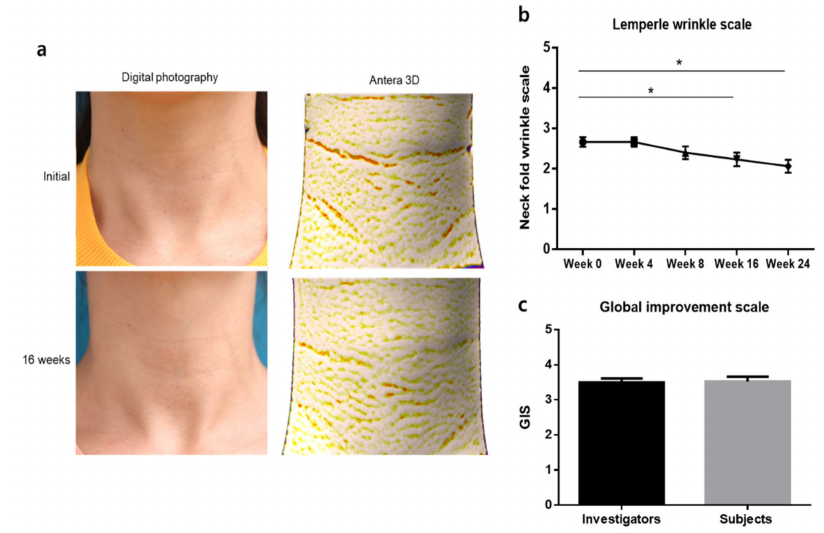
Figure 5. Improvement in neck wrinkles during the study. ( a ) Comparison of clinical photographs and Antera 3D images at baseline and at week 16. ( b ) Changes in Lemperle scale scores during the study period. ( c ) Global improvement scale scores assessed by investigators and participants. * p < 0.05, Wilcoxon singed rank test.